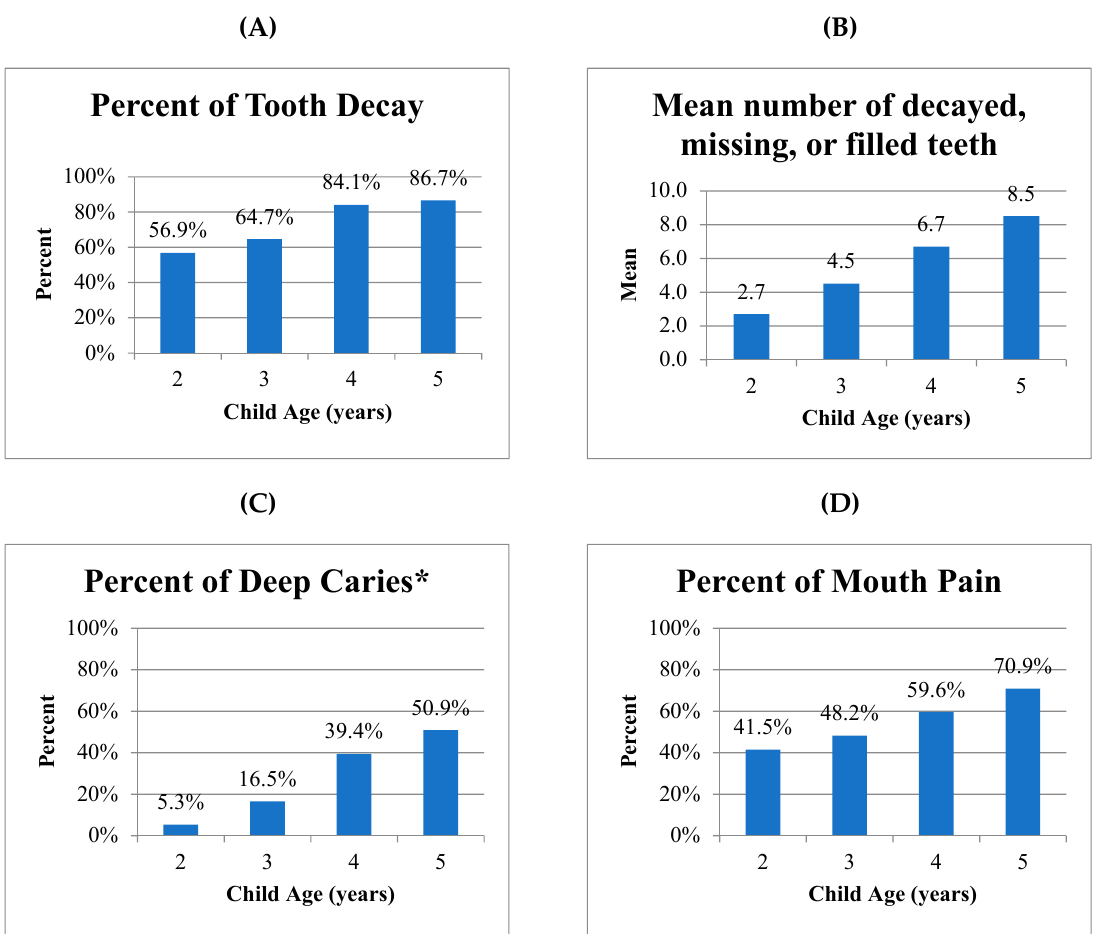
(Table 2). The prevalence of deep decay increased steadily with age to a ff ect half of the children (50.9%) at 5 years of age (Figure 1). Int. J. Environ. Res. Public Health 2019 , 16 , x